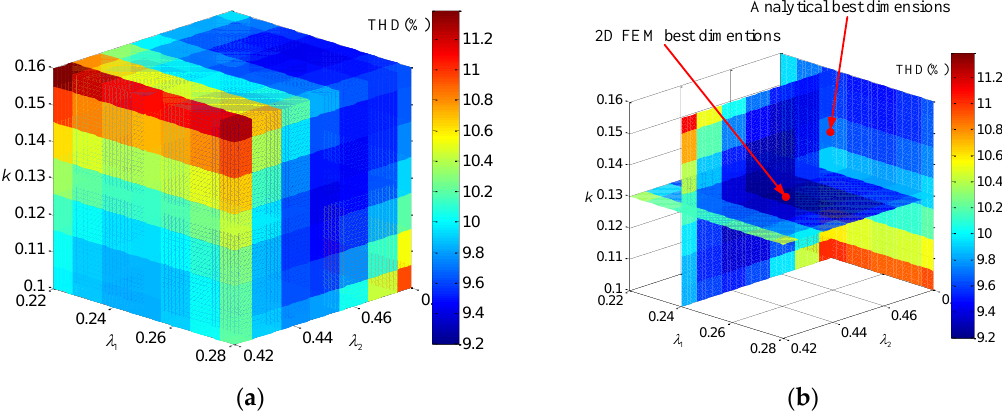
Figure 13. 2D FEM simulation results gotten by scanning multiple parameters: ( a ) database cube gotten by 2D FEM simulation; ( b ) the point of the analytical best dimensions and the point of the 2D FEM best dimensions.